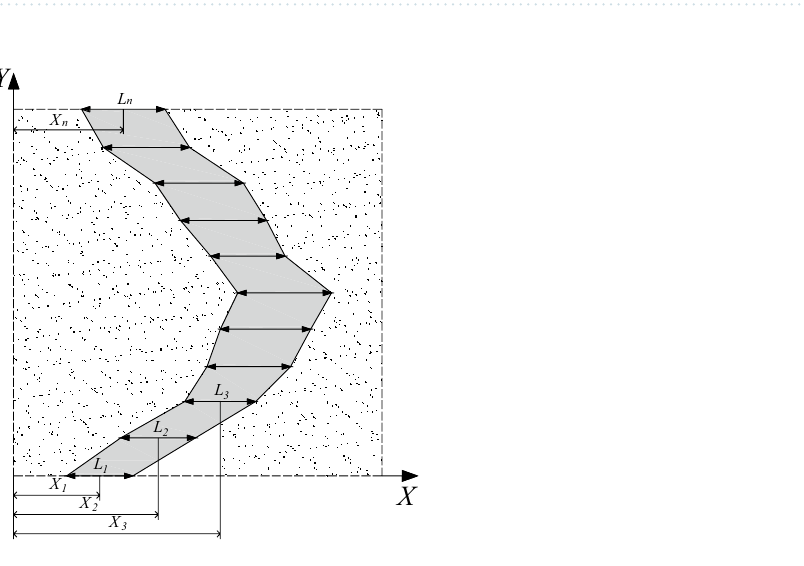
Figure 1. Geometrical model for texture shape optimization considering surface roughness (a unit cell with one dimple).